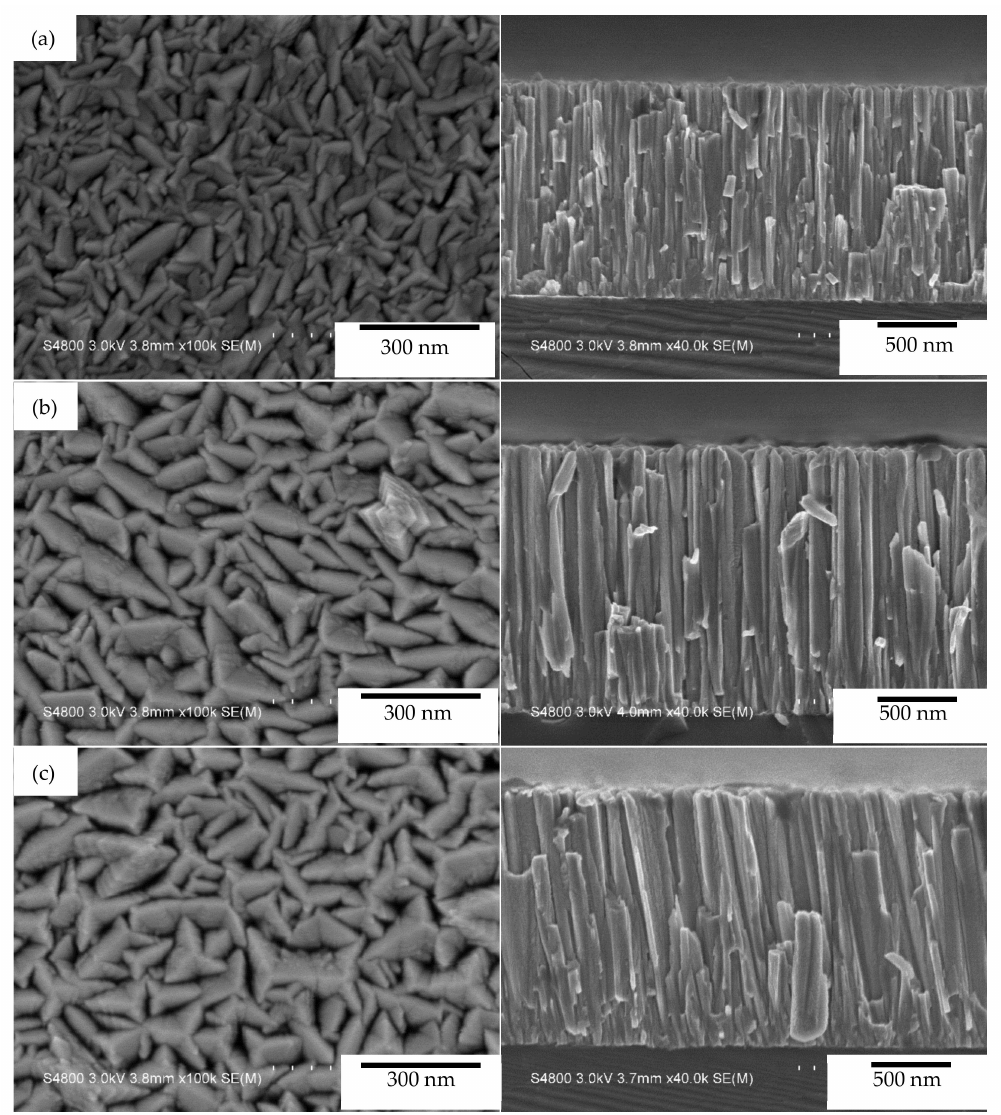
Figure 2. Top (left side) and cross-sectional (right side) SE micrographs of Cr films deposited at the substrate bias of dc − 30 V, the deposition pressure of 0.8 Pa, and the HiPIMS pulse width of ( a ) 60 µ s, ( b ) 200 µ s, and ( c ) 360 µ s, on a silicon